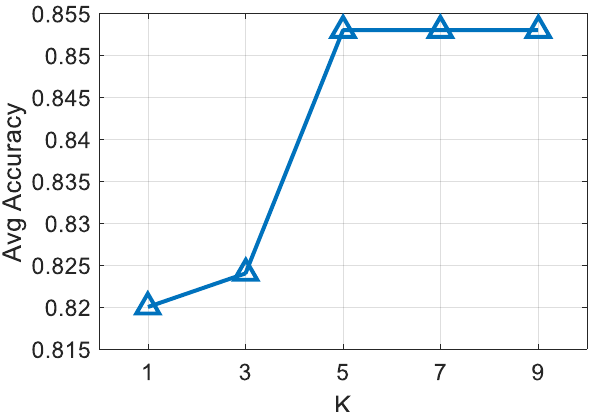
Figure 5. Performance of our RANet on validation set with varying values of K . The results indicate the average accuracy of recognizing porn and normal